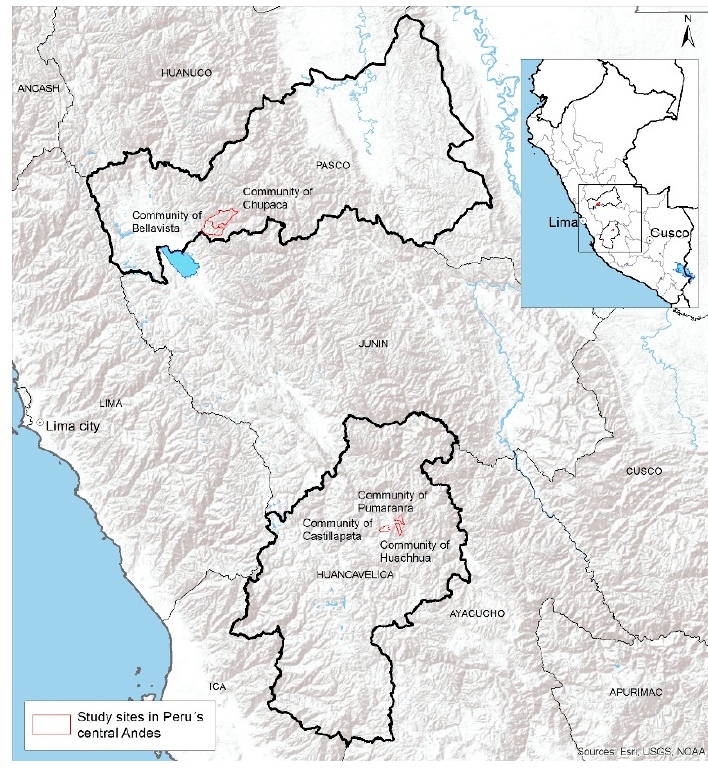
Figure 1. Study sites in Peru’s central Andes. Table 1. Study sites in Peru’s central Andes.